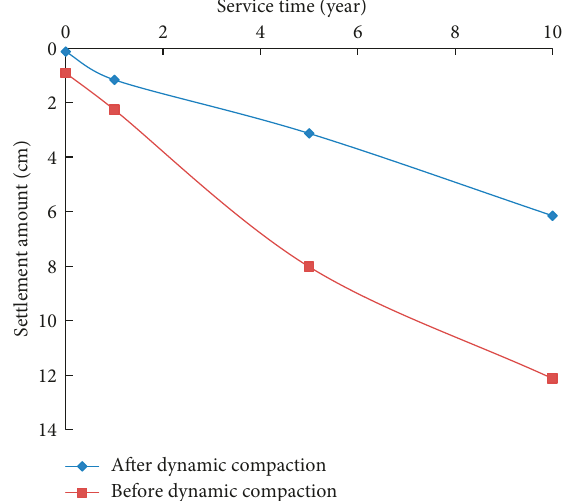
Figure 10: The postconstruction settlement with changes in service